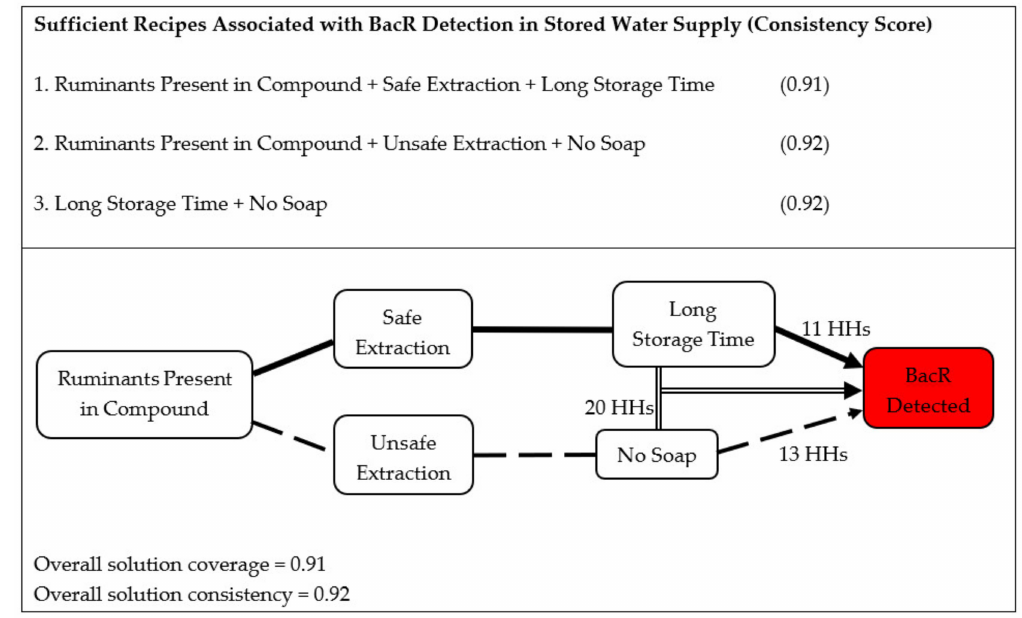
Figure 4. Combinations of causal conditions that are associated with the BacR molecular marker being detected in a household’s stored water supply, their consistency scores, and the number of households they explain. Each line type represents one combination; there are three in total: (i) ruminants + safe extraction + long storage time, (ii) ruminants + unsafe extraction + no soap, and (iii) long storage time + no soap. A household’s contamination may be explained by more than one